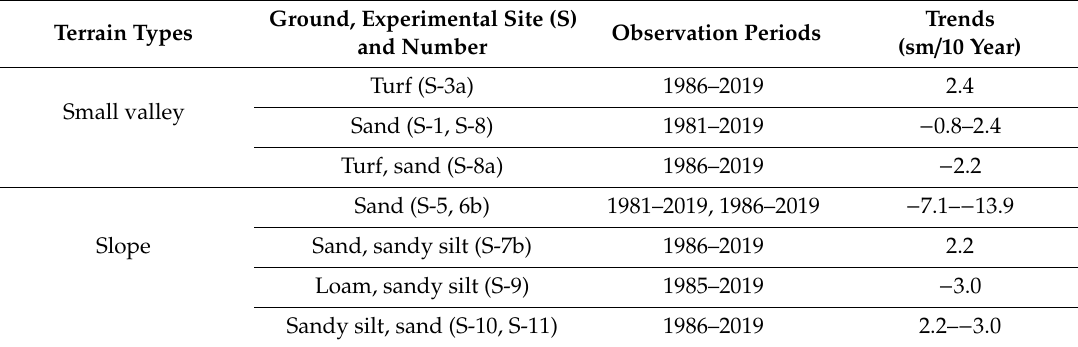
Table 6. Trends in the depth of seasonal thawing of soils of the Chabyda station. Terrain